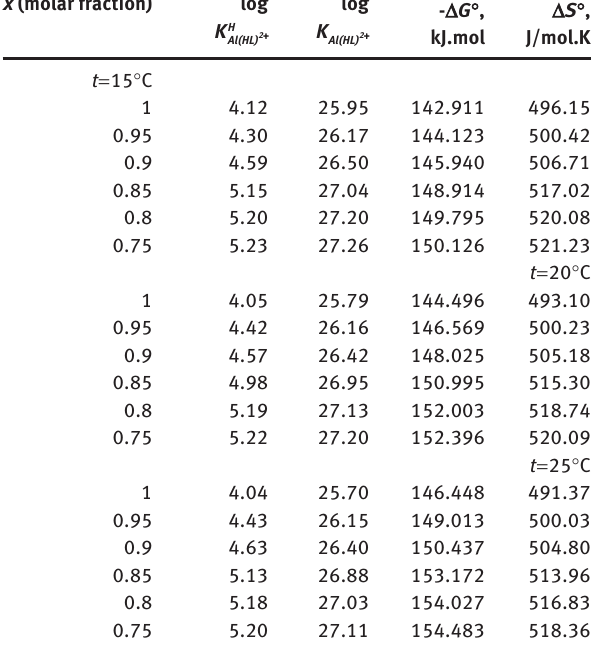
and K H , Δ G ° and Δ S ° of Al(III) Al(HL) 2 + Al(HL) 2 +